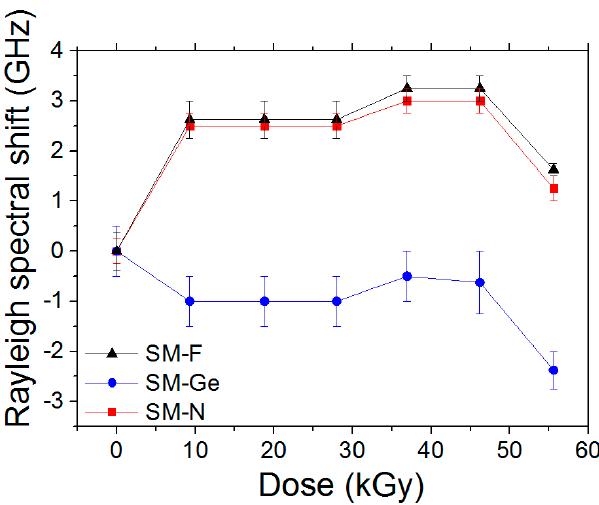
Figure 10. Rayleigh spectral shift as a function of dose, for the F-doped, Ge-doped and N-doped fibers.